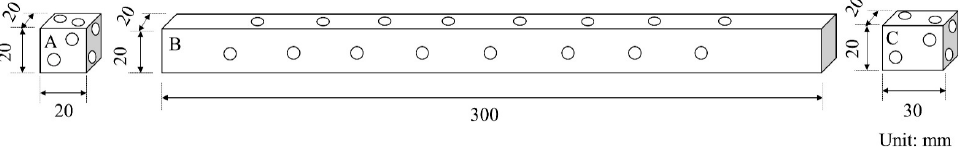
Figure 2. Diagram of the spectral collection position of the mechanical property samples. A: Density sample; B: bending sample; C: compressive strength parallel to grains sample.